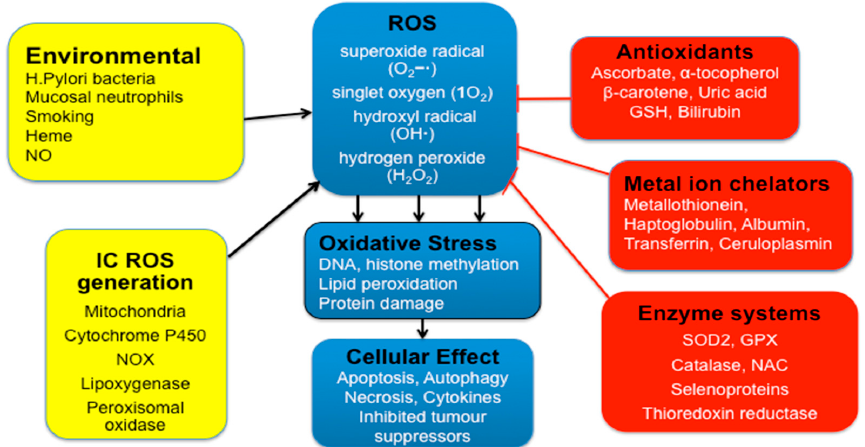
Figure 3. Contribution of environmental and intracellular (IC) sources of reactive oxygen species (ROS) with resulting oxidative stress and activation of oncogenes and inflammation. This can be modified by endogenous antioxidant systems, metal ion chelators and ingested phytochemicals including vitamin C (ascorbate) [30].